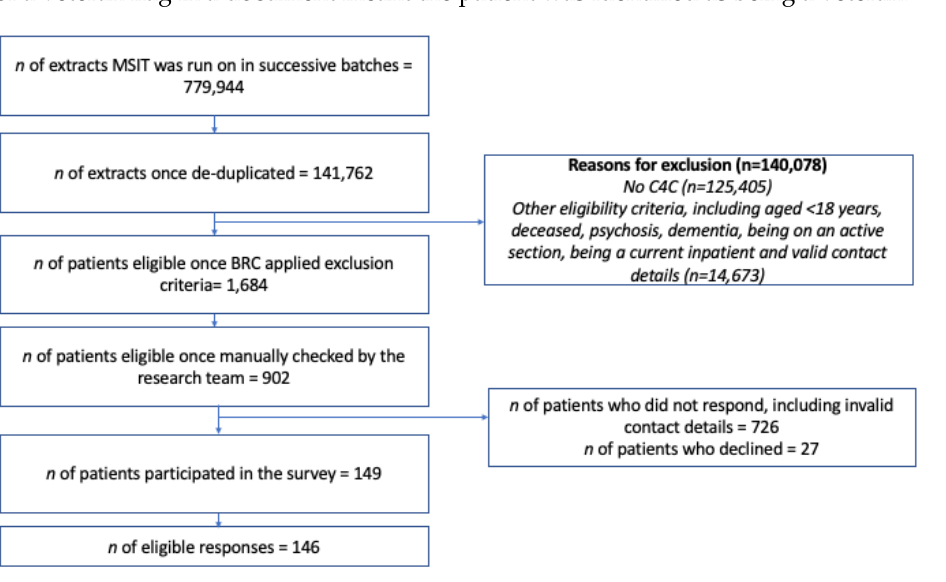
Figure 1. Flow diagram of the recruitment process for the MSIT validation study.